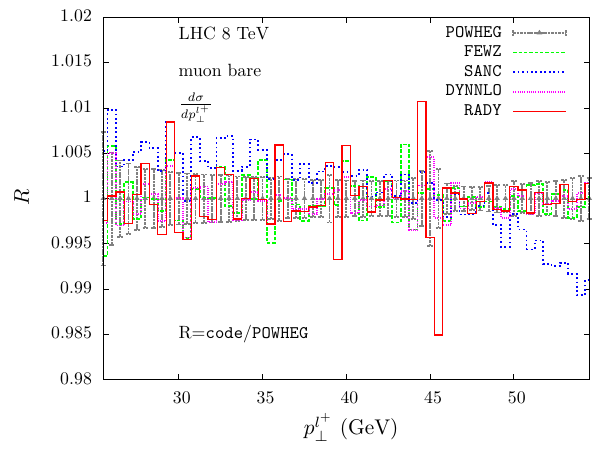
Fig. 14 Tuned comparison of the muon transverse momentum dis- tributions in pp → γ, Z → μ + μ − + X at the 8 TeV LHC with ATLAS/CMS cuts in the bare setup, including NLO QCD corrections